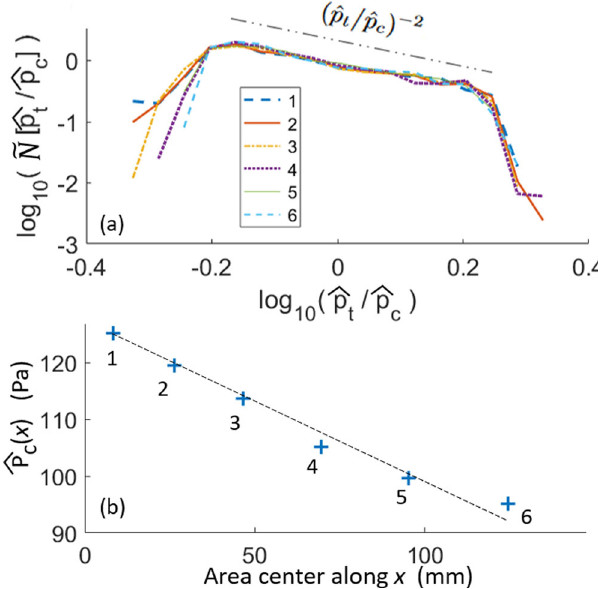
Fig. 2 Statistical description of the porous model. a Probability density function ~ N of ^ p t ð x ; y Þ = ^ p c in the six areas (denoted 1 to 6) de fi ned in Fig. 1 on the 3D printed model. This distribution is conserved in our model and, around ^ p t ¼ p c it scales approximately as ð ^ p t = ^ p c Þ (cid:3) 2 , as highlighted by the dash-dotted line. Note: the average pore connectivity in our model being 3, we de fi ned the percolation pressure ^ p c such that 26,31 b Evolution of the critical capillary pressure ^ p c along the model (crosses), arising from its intrinsic structure. The straight line shows a linear fi t, which is a fi rst-order approximation of ^ p c (the engineered gradient in the model was actually in grain size and not in percolation pressure). To this gradient, one can compute an equivalent model tilt (see Fig. 1):